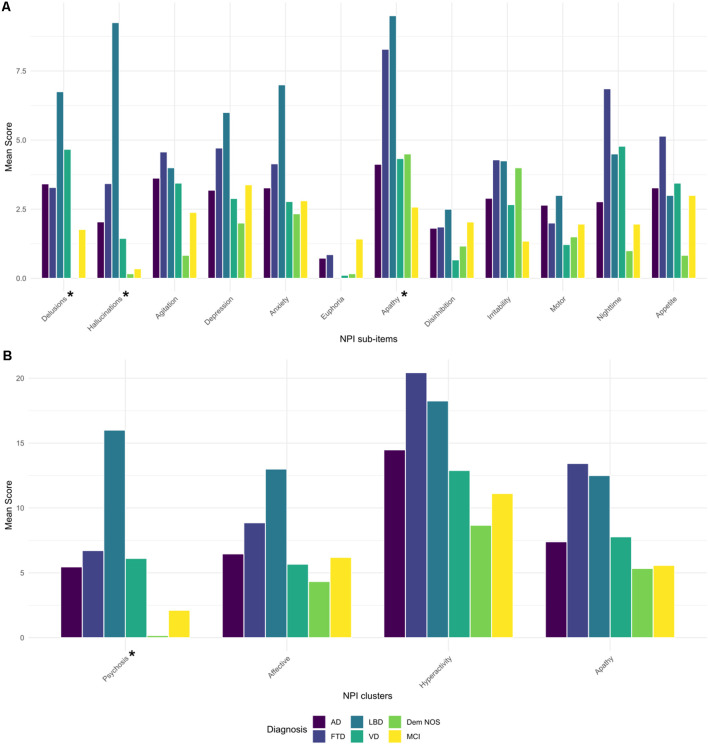
Barplot of mean scores of NPI sub-items (A) and NPI clusters (B) by diagnostic groups. AD, Alzheimer’s disease; FTD, frontotemporal dementia; Dem NOS, demented not otherwise specified; LBD, Lewy body dementia; MCI, mild cognitive impairment; NPI, Neuropsychiatric Inventory; VD, Vascular dementia. *Significance tests used were Kruskal–Wallis: Delusions (p < 0.05), Hallucinations (p < 0.001), Apathy (p < 0.01), Psychosis cluster (p < 0.05). Post hoc pair-wise comparisons with Bonferroni correction: Hallucinations: LBD > MCI and AD (p < 0.001 and 0.05, respectively), Psychosis cluster: LBD > MCI (p < 0.05).